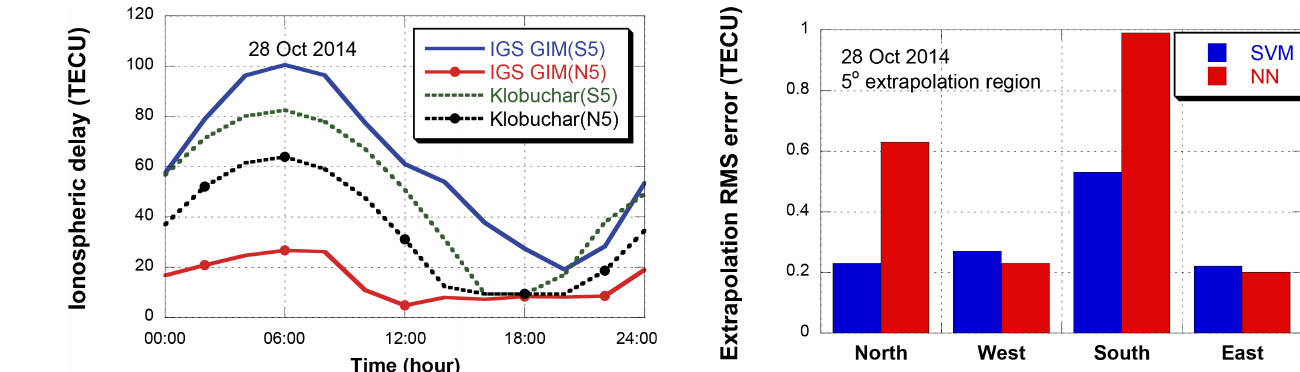
Figure 7. Ionospheric delays of the IGS GIM and Klobuchar model (south 5 ◦ and north 5 ◦ points).